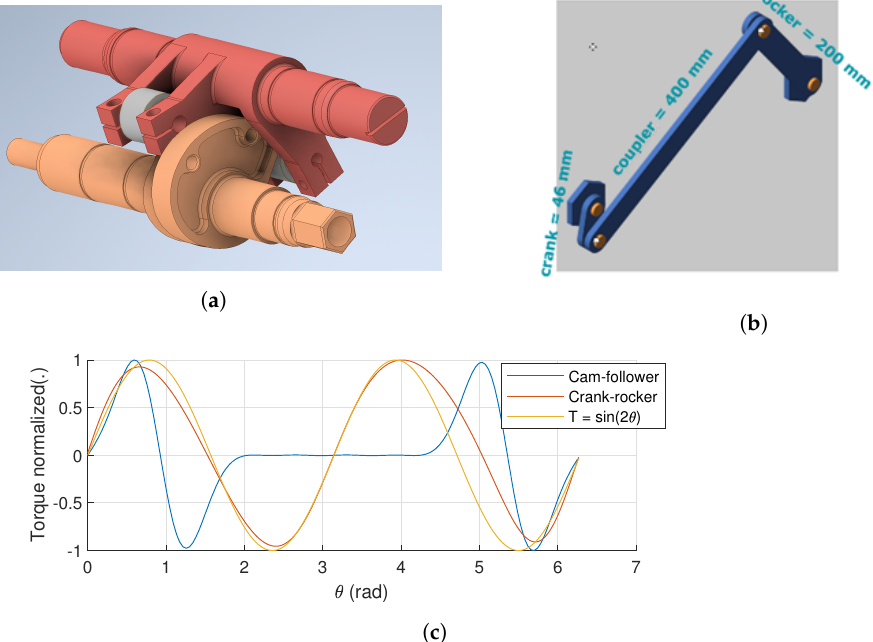
Figure 1. Magnetic spring characteristic requirements for highly dynamic reciprocating